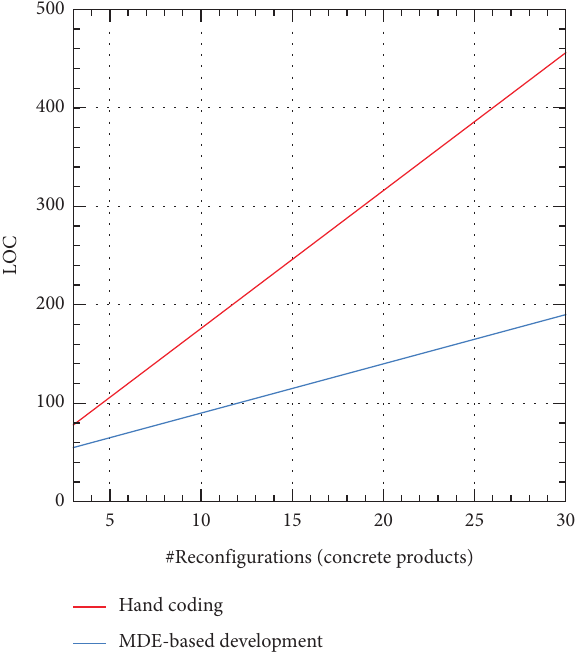
Figure 23: Relationship between LOC and the number of components.